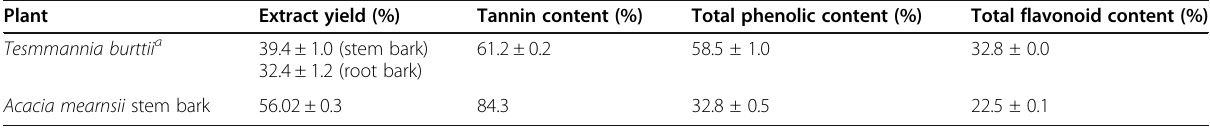
Table 2 Tannin content, total phenolic content and total flavonoid content of the T. burttii extracts extracted at 50 °C Plant